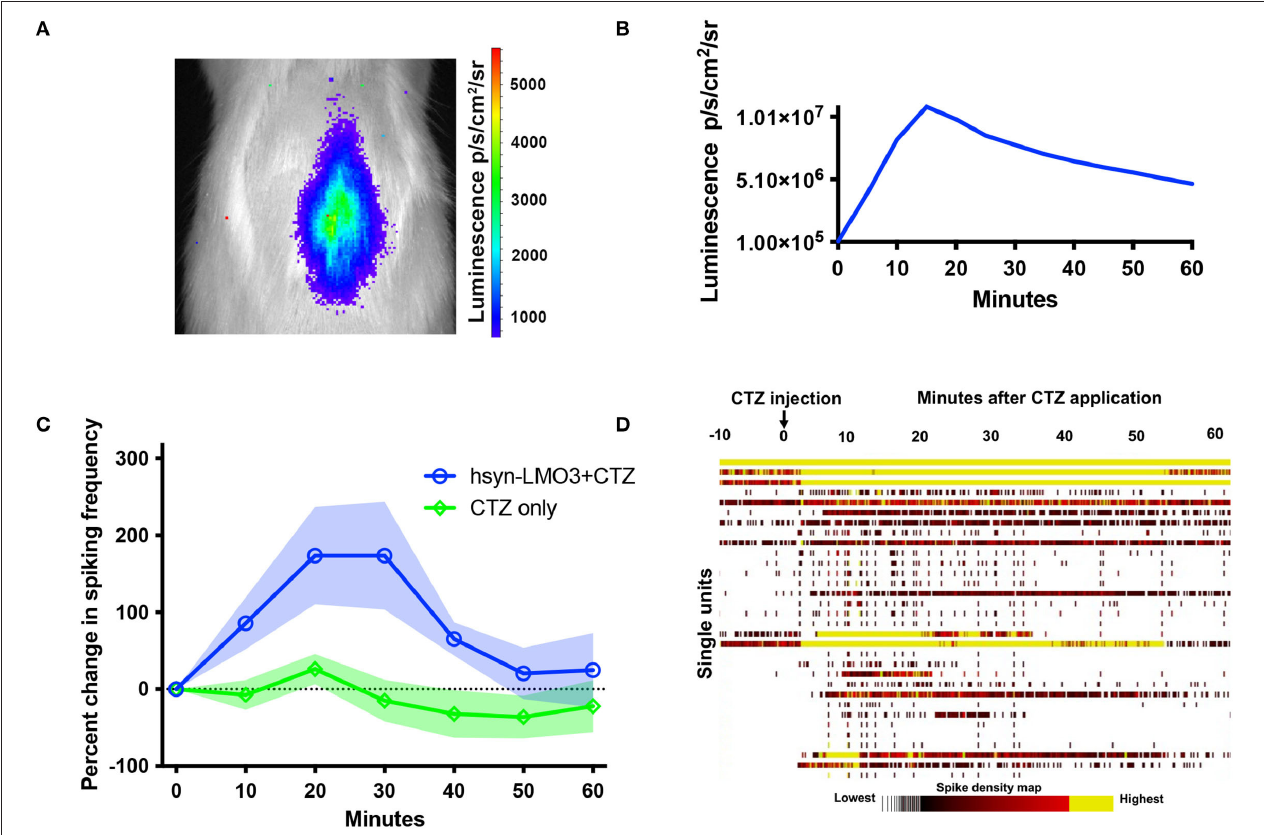
FIGURE 2 | Bioluminescent optogenetic stimulation of spinal cord neurons. (A) Example of in vivo bioluminescent imaging of a rat expressing LMO3 in the lumbar spinal cord following CTZ infusion through the lateral ventricle. Luminescence (pseudocolored) is localized over the lumbar region of the cord. (B) A representative trace of luminescence over time following CTZ infusion in the lateral ventricle. (C) Single unit electrophysiological response in the lumbar spinal cord of rats expressing AAV 2/9 hSyn-LMO3 compared to non-expressing animals when CTZ is infused through the lateral ventricle. Similar to luminescence over time, activity increases and peaks between 10 and 30min following CTZ infusion. n = 7 for LMO3 expressing and n = 4 for non-expressing animals that received CTZ. Shading = SEM. (D) Raster plot of the response to CTZ in an LMO3 expressing